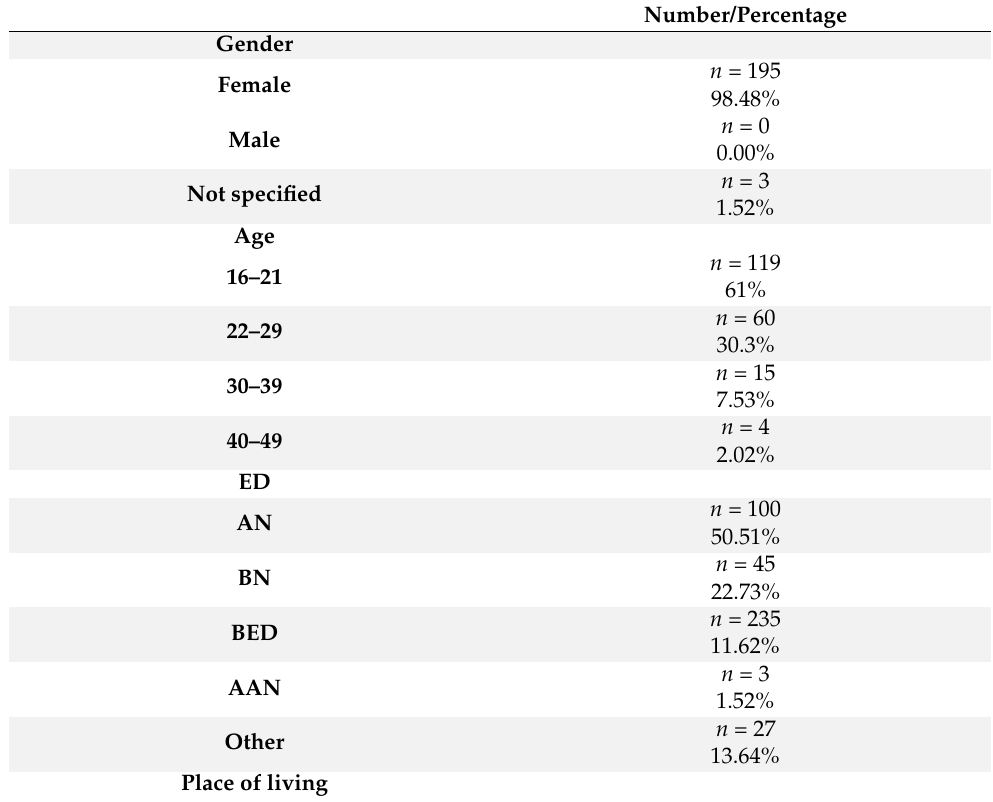
Table 1. Demographic characteristics of the